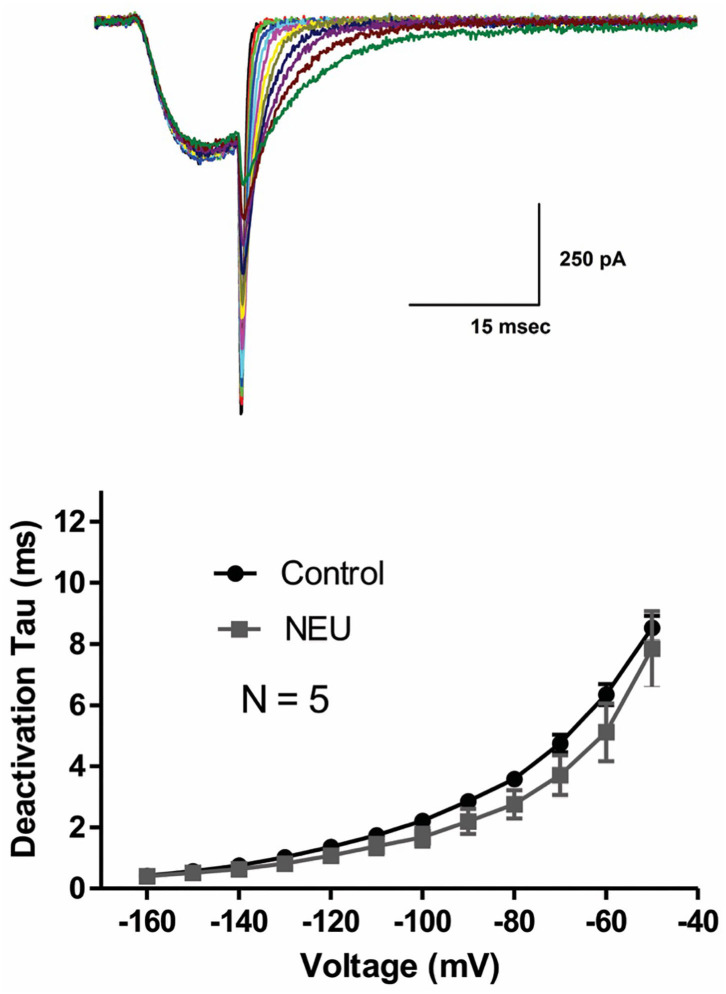
Minimal effect of NEU on deactivating CaV3.2 current kinetics. Traces on the top of this figure are taken from a representative HEK293 cells expressing CaV3.2 channels grown in hyperglycemic cell culture medium and treated with NEU for 1 h. Average graph from similar experiments in 5 untreated (control) cells and 5 treated cells is shown on lower panel of this figure. When compared with control conditions (black symbols) treatment with NEU (gray symbols) minimally affected time constant (tau) of deactivating tail current kinetics of recombinant CaV3.2 currents. We used 2 mM Ca2+ as a charge carrier in these experiments.